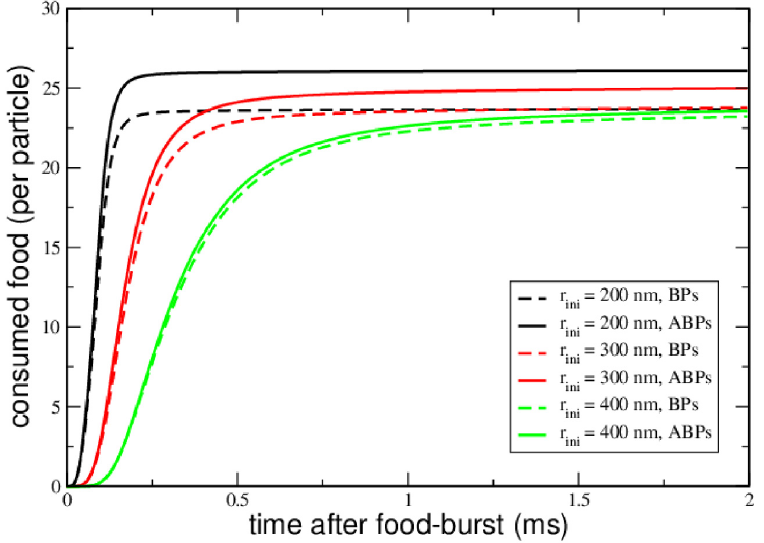
Fig 5. Food consumption in non-stationary setups. Consumed food particles as a function of time after begin of the food burst. As a result of the bias of their density distributions, ABPs consume more food than BPs, exhibiting chemotaxis. The differences diminish with increasing initial distance r ini to the center, since fewer ABPs are activated.